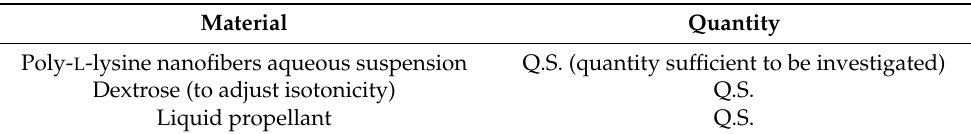
Table 2. A suggested ε -poly- L -lysine nanofibers nasal spray formulation to combat SARS-CoV-2 virus.